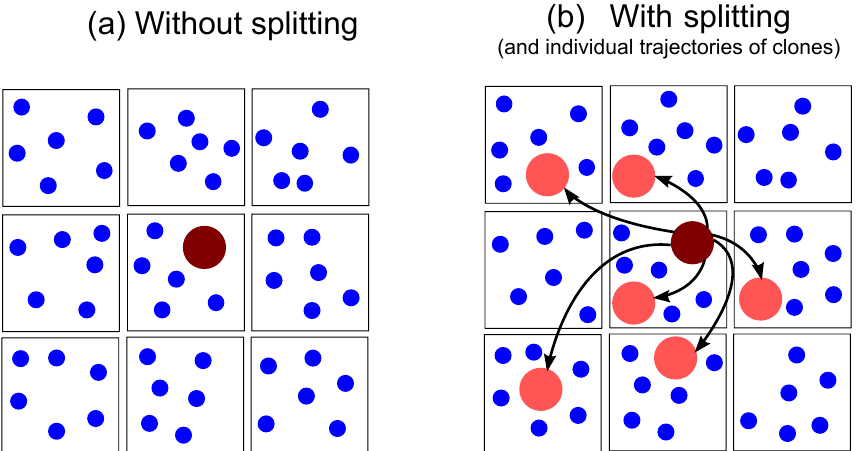
Figure 11. Schematic representation on how splitting affects the spatial distribution of large superdroplets. The squares outline the different grid boxes with superdroplets of the size of cloud droplets (blue) and superdroplets representing rain drops (dark red). Without splitting (a) , the rain drop is represented by only one superdroplet. In the splitting case with the multi-box approach (b) , this superdroplet is cloned into several superdroplets, which are able to move in other grid boxes (due to their individual subgrid-scale velocities) where they initiate or affect collisional